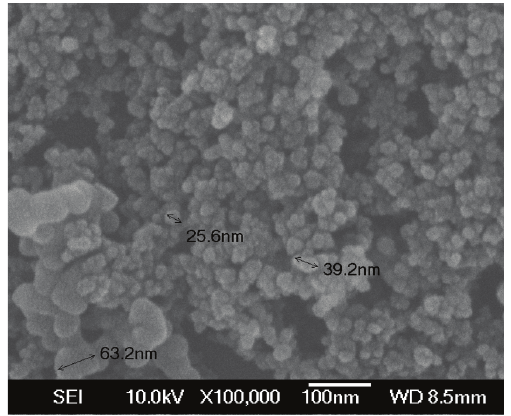
Figure 3: SEM photograph of cross section of CIGS precursor sample, revealing a sample thickness of ∼ 2 𝜇 m.